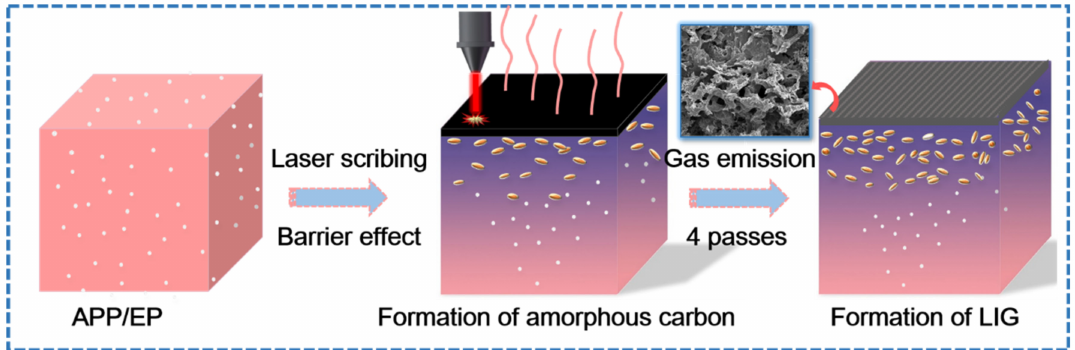
Figure 3. The growth mechanism of the LIG formed on the